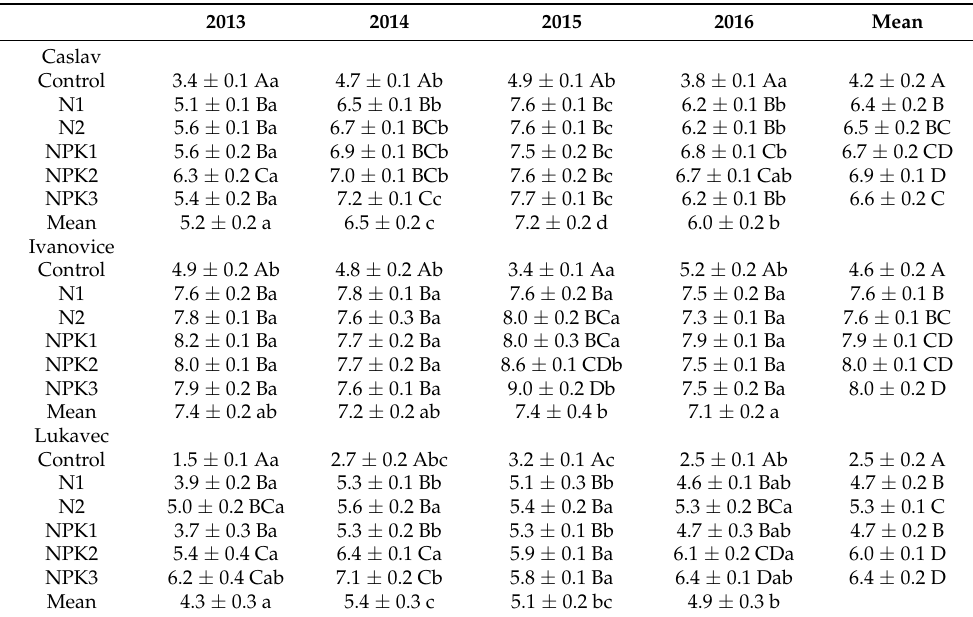
Table 3. Spring barley grain yield (t ha − 1 ) as affected by the fertilizer treatment and